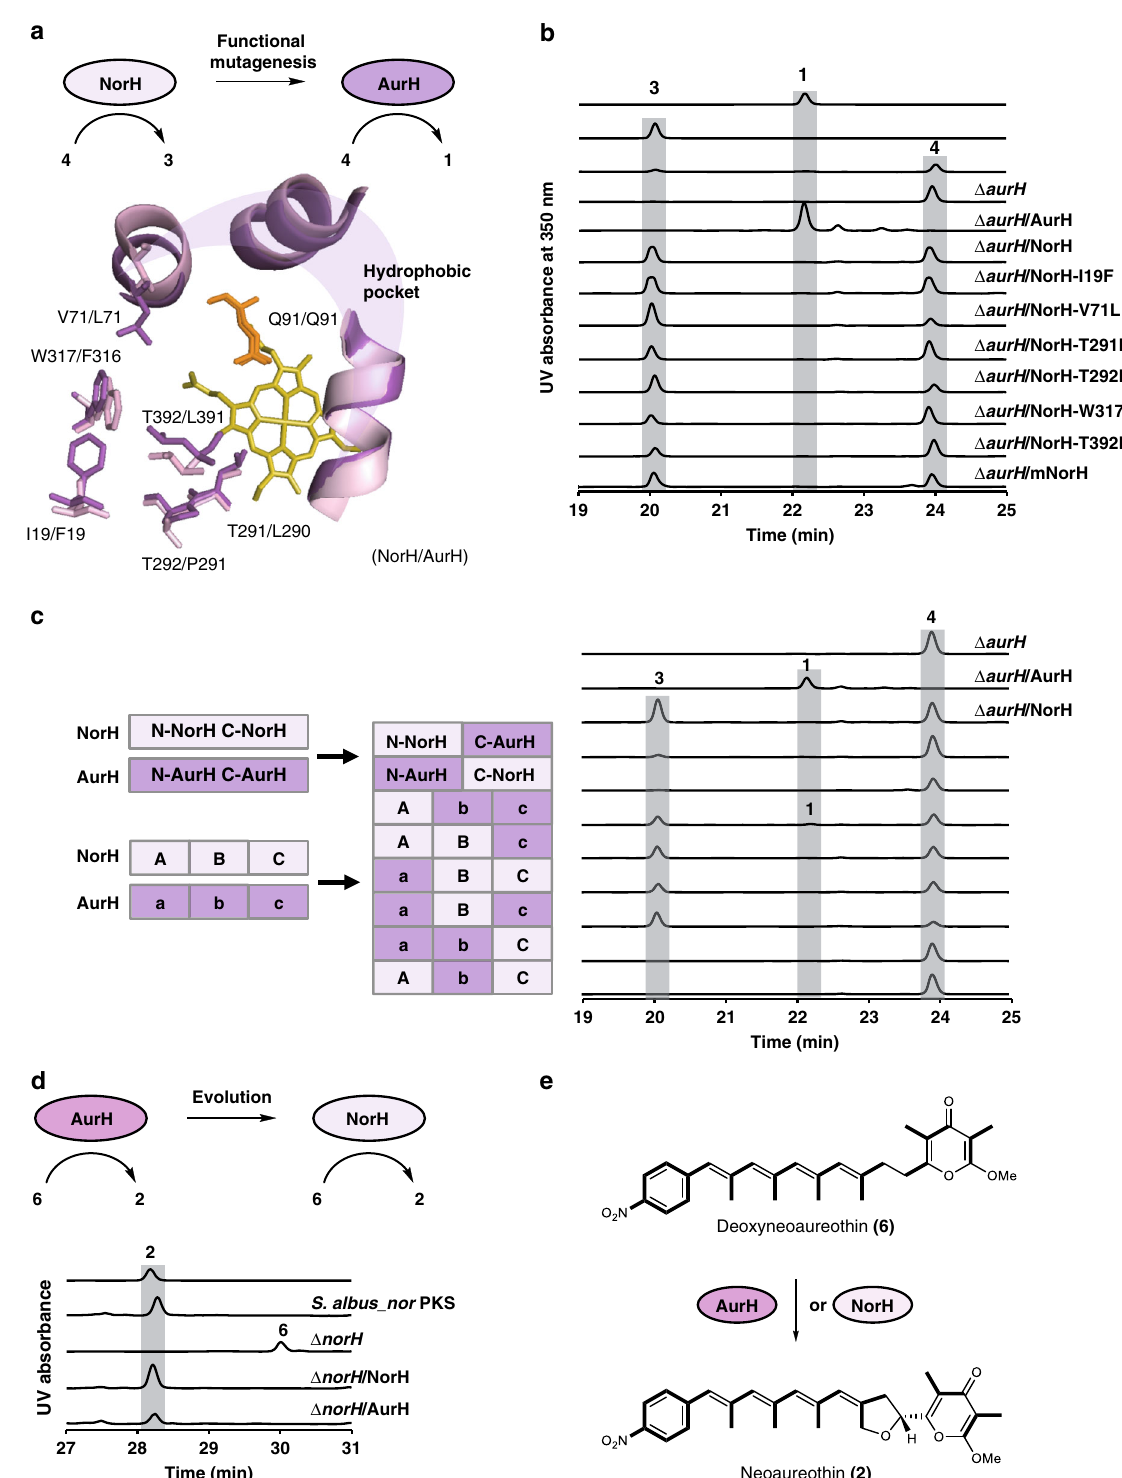
Fig. 4 Mutagenesis and comparison of oxygenase functions. a Site-directed mutagenesis of NorH. The active center of NorH/AurH model shows a hydrophobic pocket. Residues that may contribute to the different sizes of the cavity are presented in stick. The catalytic residue glutamine (orange) and the cofactor heme (yellow) are indicated. b The HPLC pro fi le of authentic standard of aureothin ( 1 ), 7-OH-deoxyaureothin ( 3 ), deoxyaureothin ( 4 ), and NorH variants. UV detection is at 350 nm. c Schematic presentation of strategies to prepare hybrid NorH/AurH variants, and pro fi ling of biotransformations. The hybrid NorH/AurH variants (left panel) correspond to HPLC pro fi les of extracts (right panel) of those variants. UV detection at 350 nm. d The HPLC pro fi le of authentic standard of 2 and S. albus mutant strains. e AurH and NorH catalyze the biotransformation from 6 to